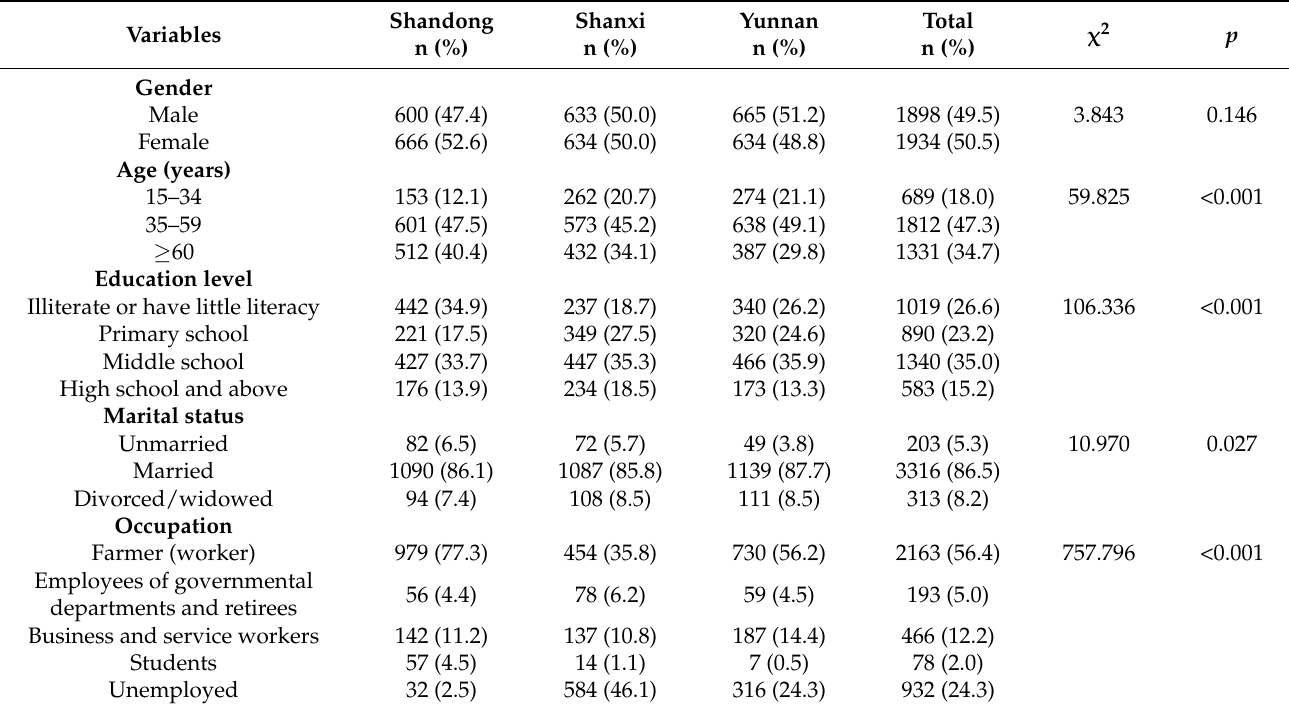
Table 1. Characteristics of 3832 rural